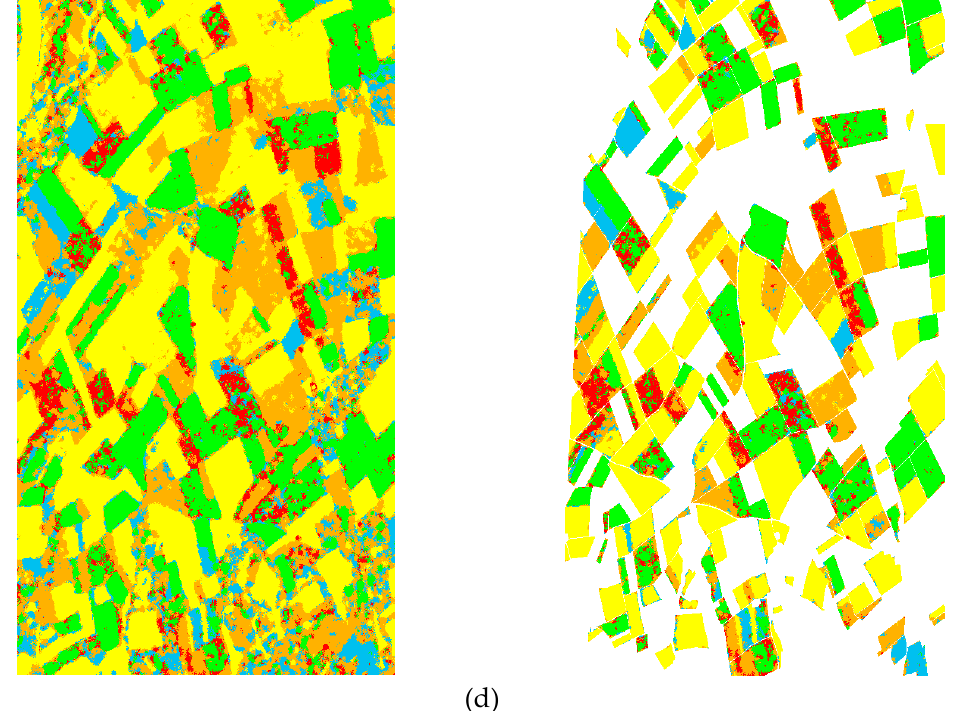
Figure 6. Pixel-based classification results for the Wallerfing data. The left column shows the classification results, and the right column shows the corresponding classification results where the ground-truth map exists. ( a ) WMRF. ( b ) KMRF. ( c ) MWMRF. ( d ) MWMRF/e.